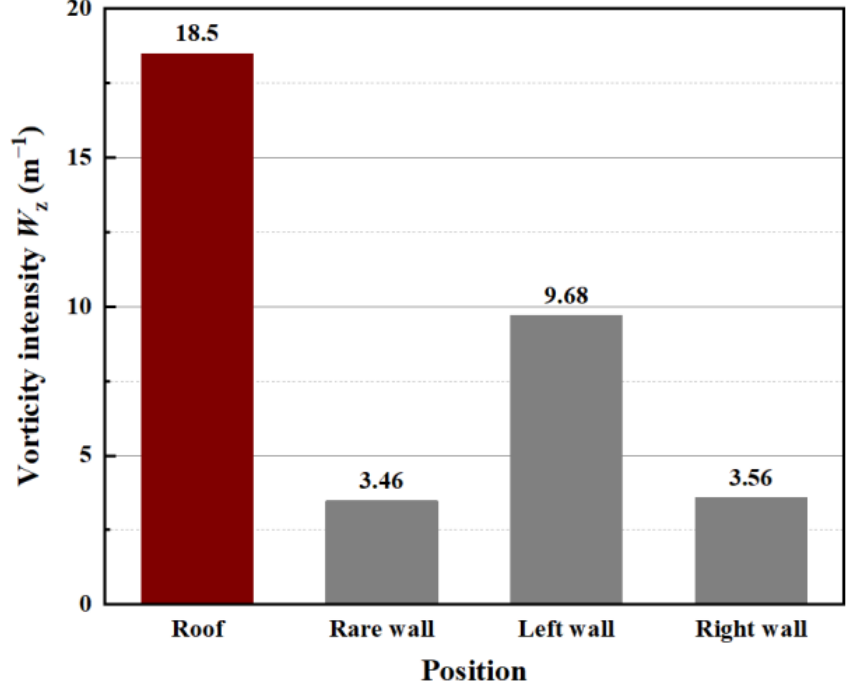
Figure 19. Maximum vorticity intensity of each wall.